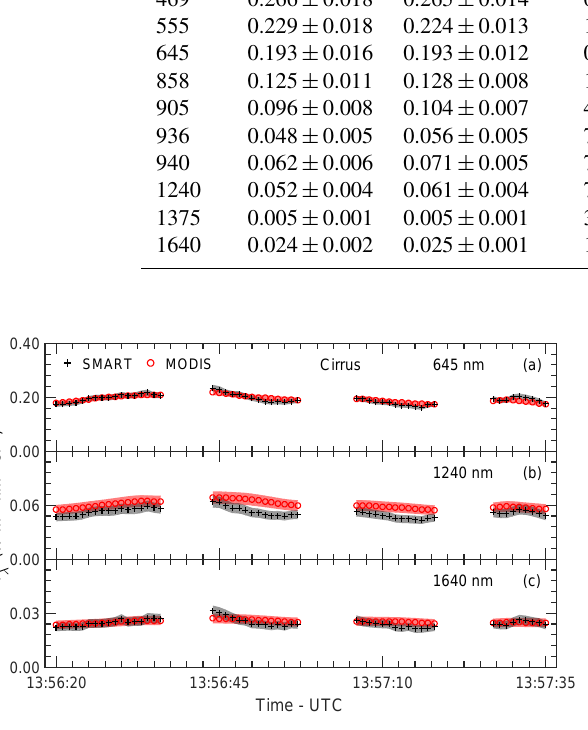
↑ Figure 4. Time series of I centered at λ = 645nm (a) , λ 1240nm (b) , and 1640nm (c) measured by SMART (black) and MODIS (red) for the cirrus case. Shaded areas are measurement uncertainties. Gaps on the time series indicate when the shutter of SMART closed for dark current